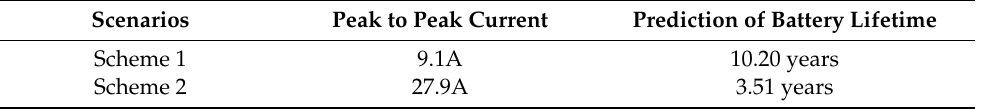
Table 3. Battery lifetime prediction result.